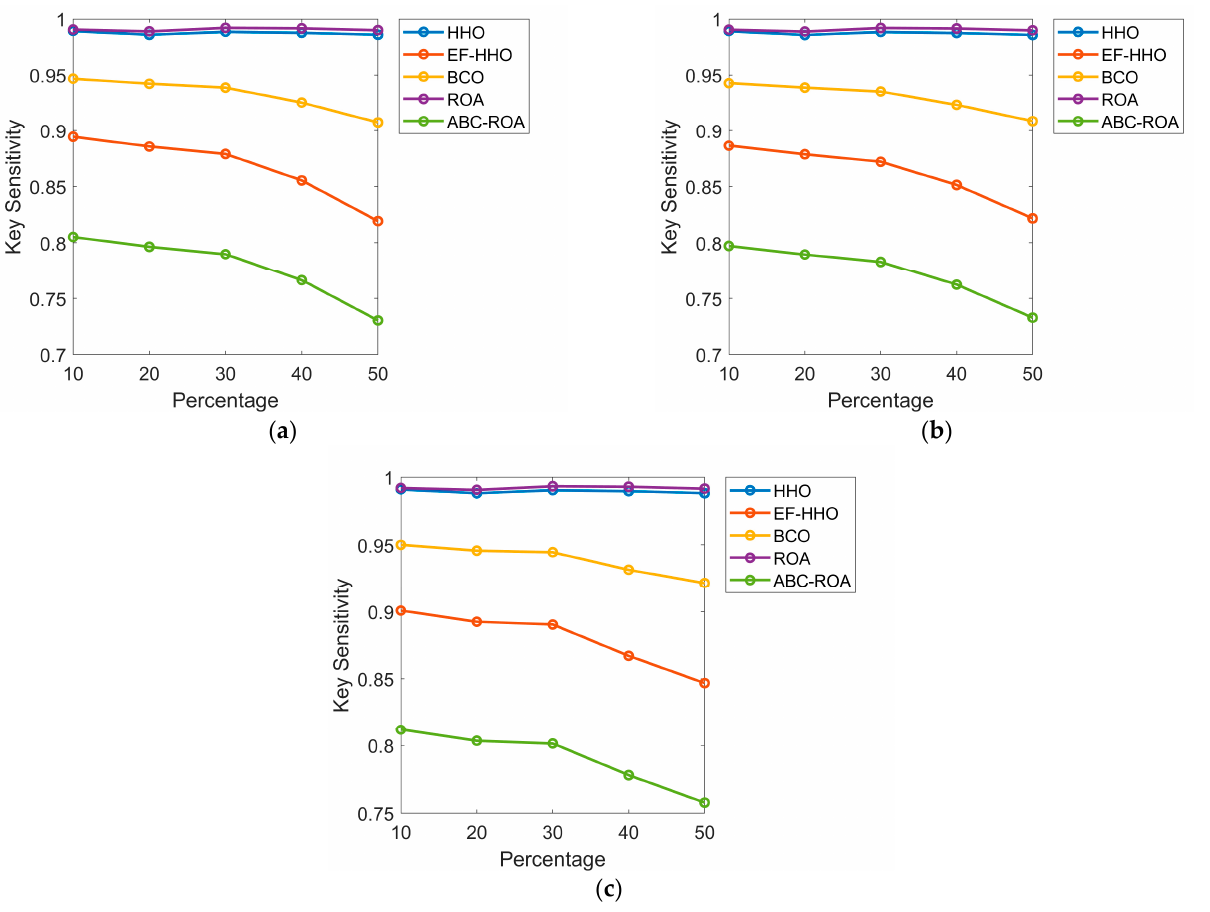
Figure 9. Performance analysis of the designed blockchain-based privacy preservation model con- cerning ( a ) dataset 1, ( b ) dataset 2, and ( c ) dataset 3.